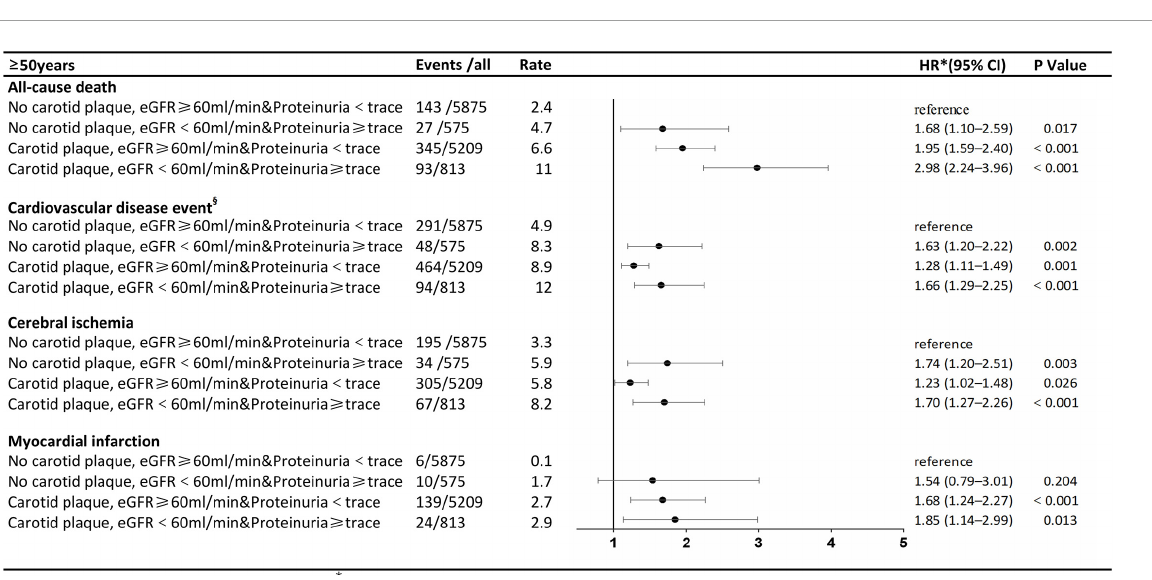
FIGURE4 Association of carotid plaque and renal impairment with all-cause death and cardiovascular disease events in subgroups stratified according to age.